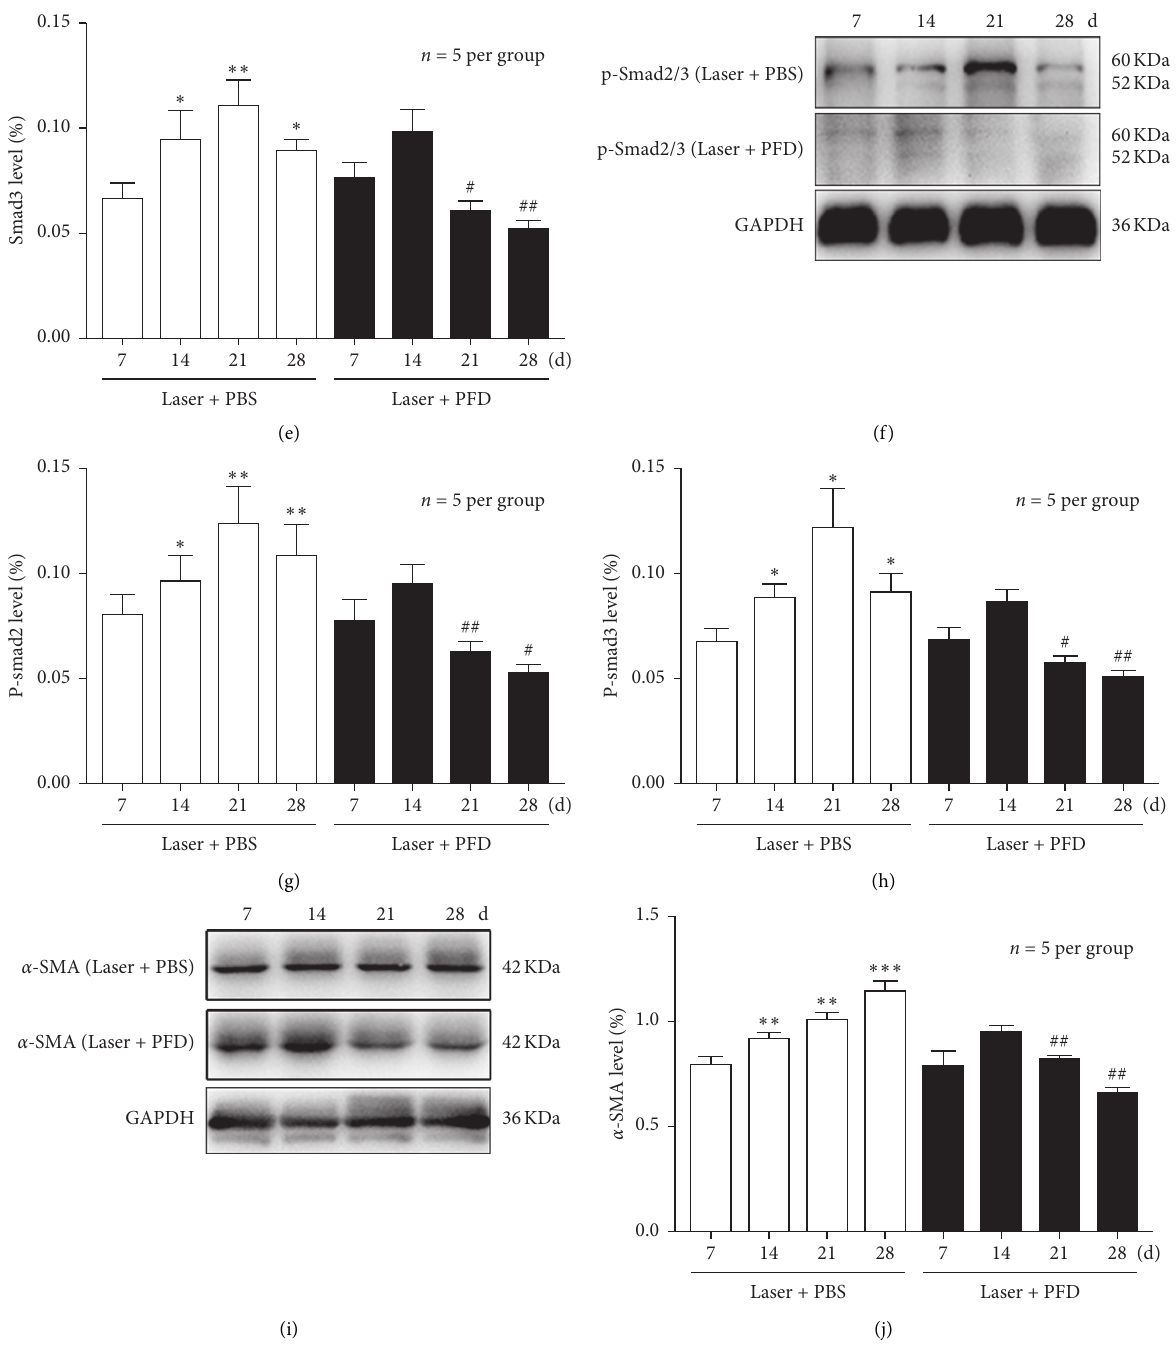
Figure 2: Intravitreal injection of PFD attenuates the formation of fibrosis. Representative images of collagen I (red) staining of the retinal pigment epithelium-choroid-sclera flat mounts obtained from the three groups. Scale bar: 200 µ m. Quantitative measurement of the fibrosis area. ∗∗ P < 0 . 01 vs. Laser and Laser+PBS. # P < 0 . 05 vs. day